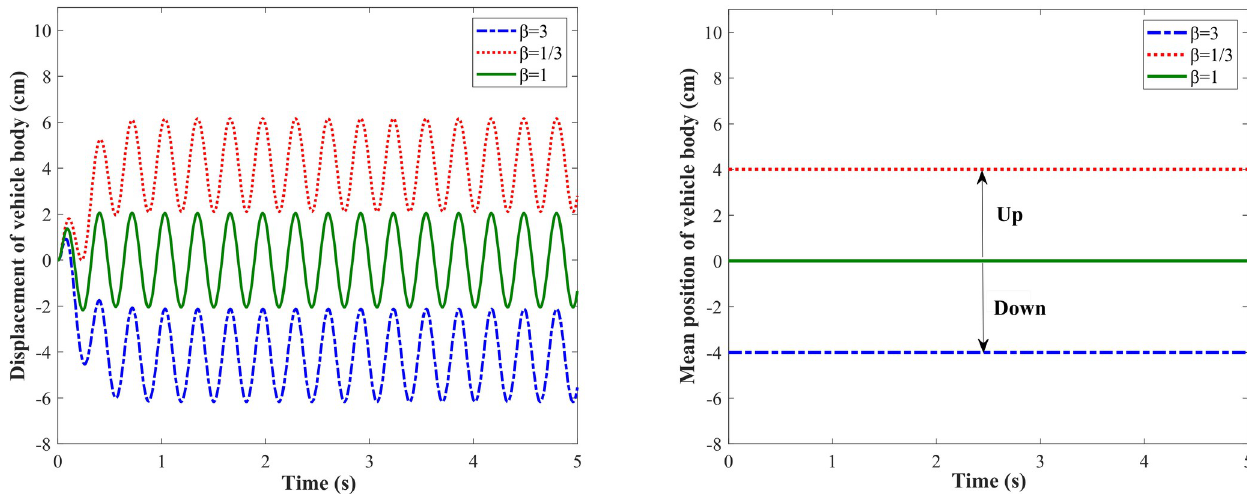
Fig 4. Vehicle body responses under sinusoidal road excitation. (A) Displacement of the vehicle body; (B) Mean position of the vehicle body.